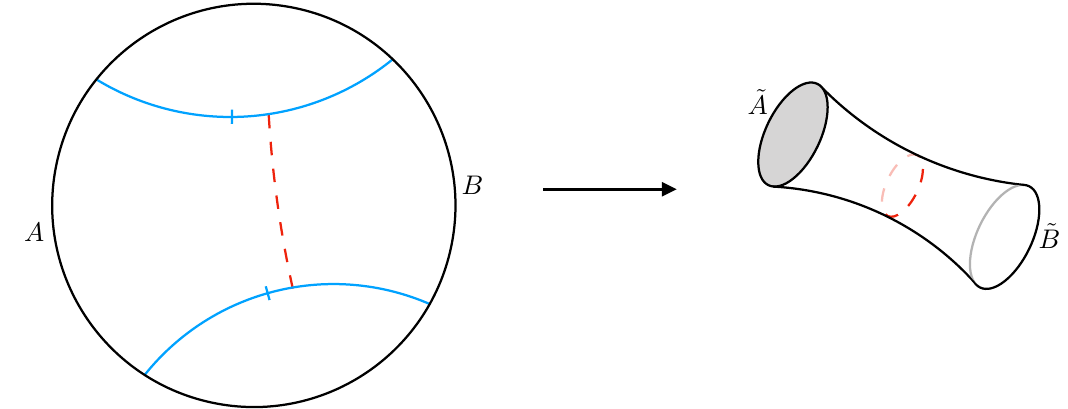
Figure 6 . The two-surface identi(cid:12)cation used to make the two-sided wormhole geometry. Notches indicate the identi(cid:12)cation of the two blue surfaces with each other in the left sub(cid:12)gure, creating the wormhole geometry depicted in the right sub(cid:12)gure. Crucially, the minimal surface connecting the identi(cid:12)ed geodesics (depicted here by a red dashed line) maps onto the horizon area in the wormhole